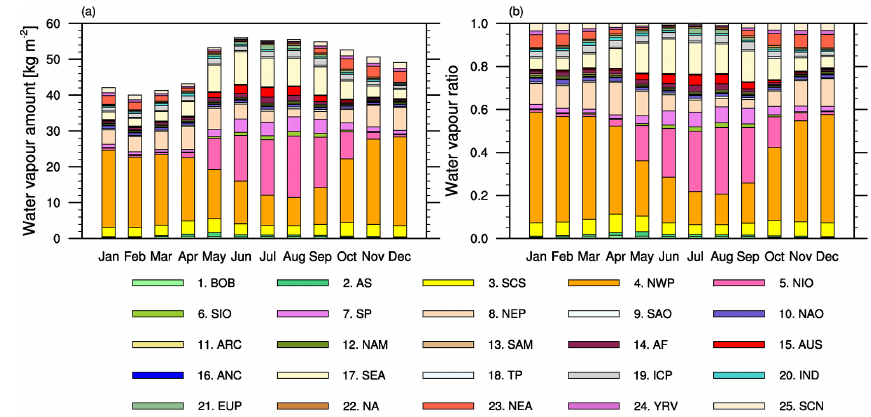
Figure 8. (a) Monthly averaged evolution of evaporative contribution of 25 defined source regions to the tropospheric total water vapour amount over the SCS. (b) Same as (a) , but for the relative contribution of water vapour. Stacked column colours correspond to source region colours in Fig.